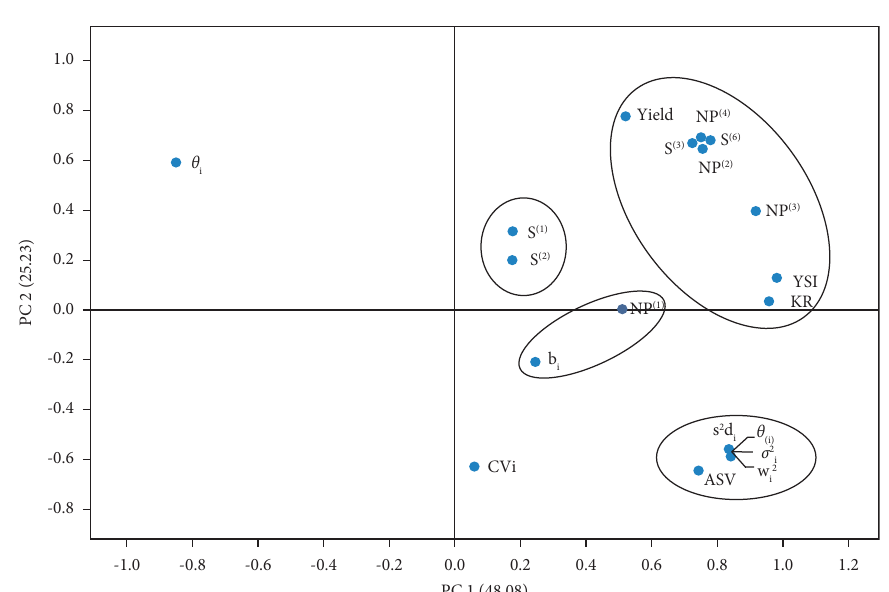
Figure 4: Principal component analysis (PCA) of parametric and nonparametric stability measurements on soybean lines in